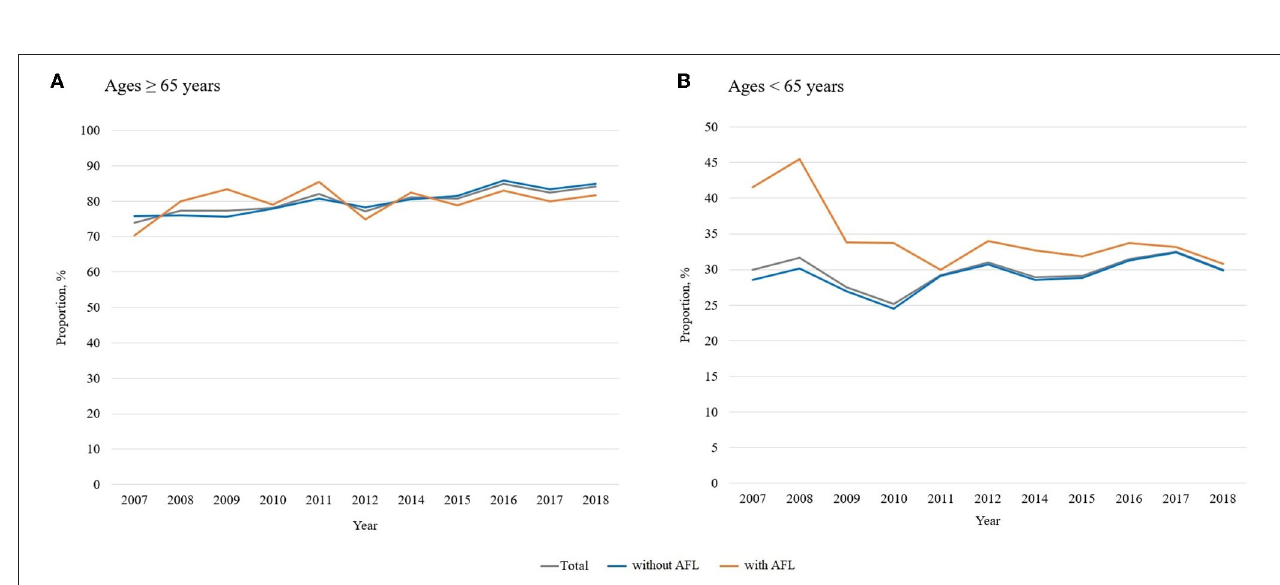
FIGURE 3 | Influenza vaccination trends according to age ( ≥ 65 vs. < 65 years). AFL, airflow limitation. (A) Age ≥ 65 years, (B) Age < 65 years. AFL, airflow limitation.